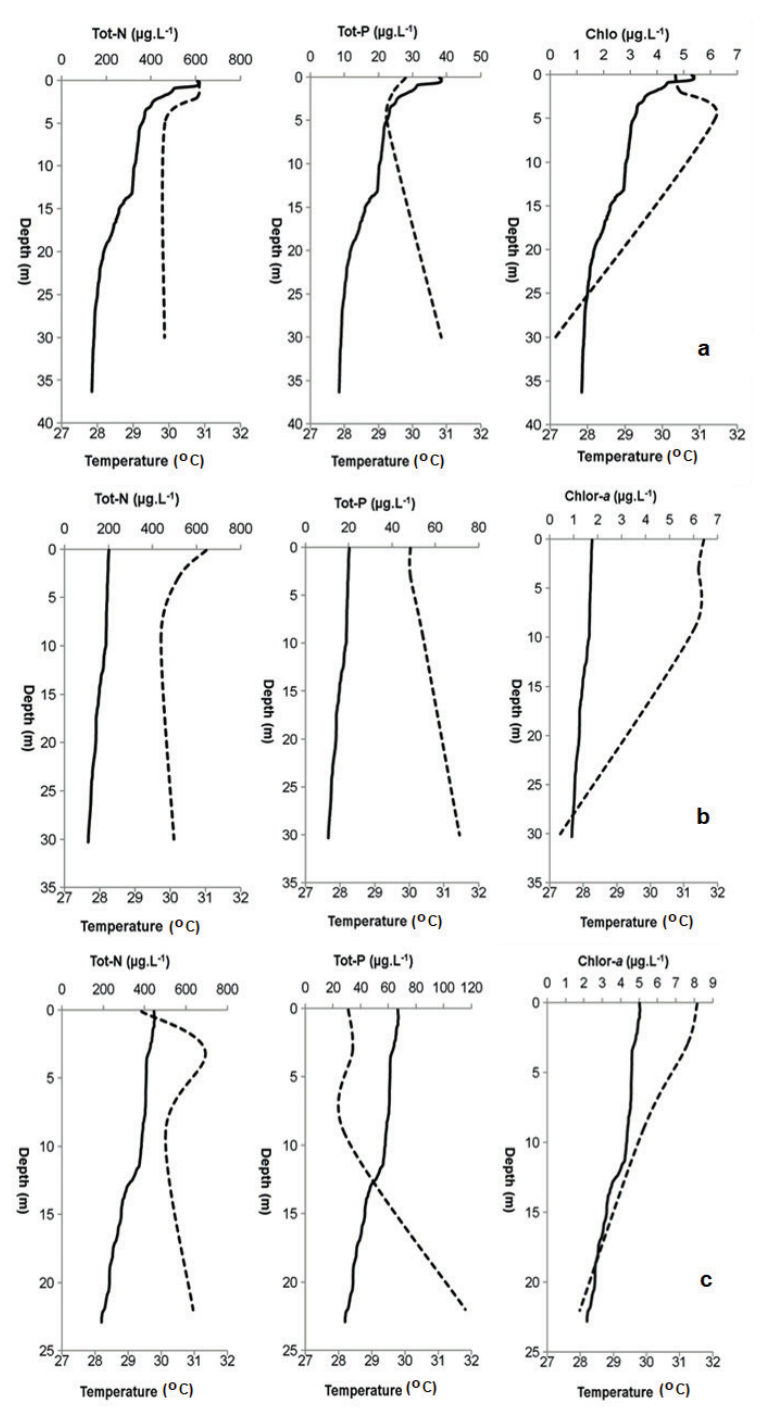
Figure 5 - Vertical profile of chlorophyll -a , phosphorus and nitrogen concentrations in station 7 (location in Figure 1) in the Castanhão reservoir, NE Brazil. a ) March 2012; b ) January 2013; c ) May 2014. Bold line = Temperature; Dotted line = Variables. Since we have used a probe for chlorophyll quantification in the profile, values may include other pigments, in particular below 10-12 m of